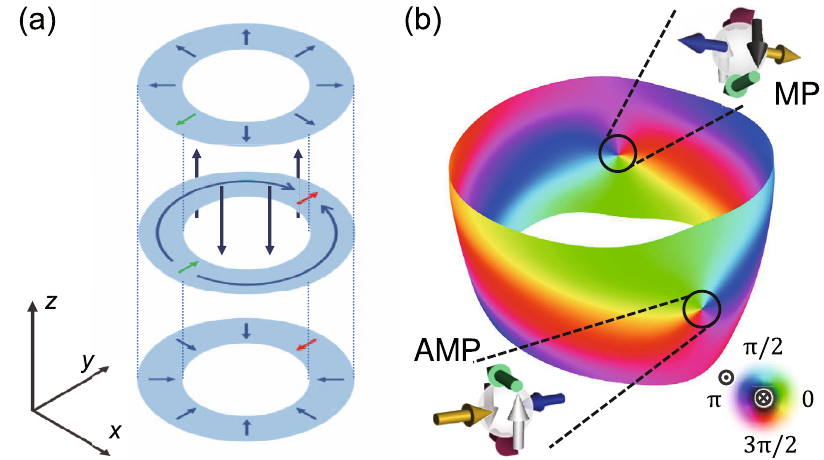
Fig. 1 Emergent monopole-antimonopole pair in the 3D structure of type-II bubbles. a A sketch of the 3D structure of a type-II bubble. b The contour surface with m z = 0 of a simulated bubble and diagrams of the MP-AMP pair on it. The sample is de fi ned as 2 μ m × 2 μ m × 200 nm size with cells of 4 nm × 4 nm × 4 nm. The simulation is performed with a perpendicular easy axis at a perpendicular external fi eld of 0.06 T. Other parameters are the same as in the main text. The color represents the direction of magnetizations as a conventional color wheel at the right bottom corner. The contour surface is drawn with the software Spirit 35 .